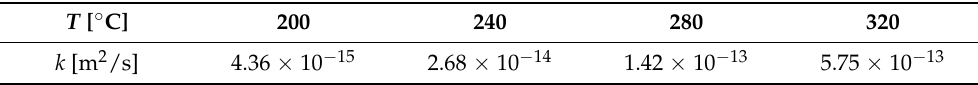
Figure 11. Relationship between the square of the diffusion layer and annealing time of the Al/Zn laminate composite plate. Table 3. Growth rates of the diffusion layer at different annealing temperatures.